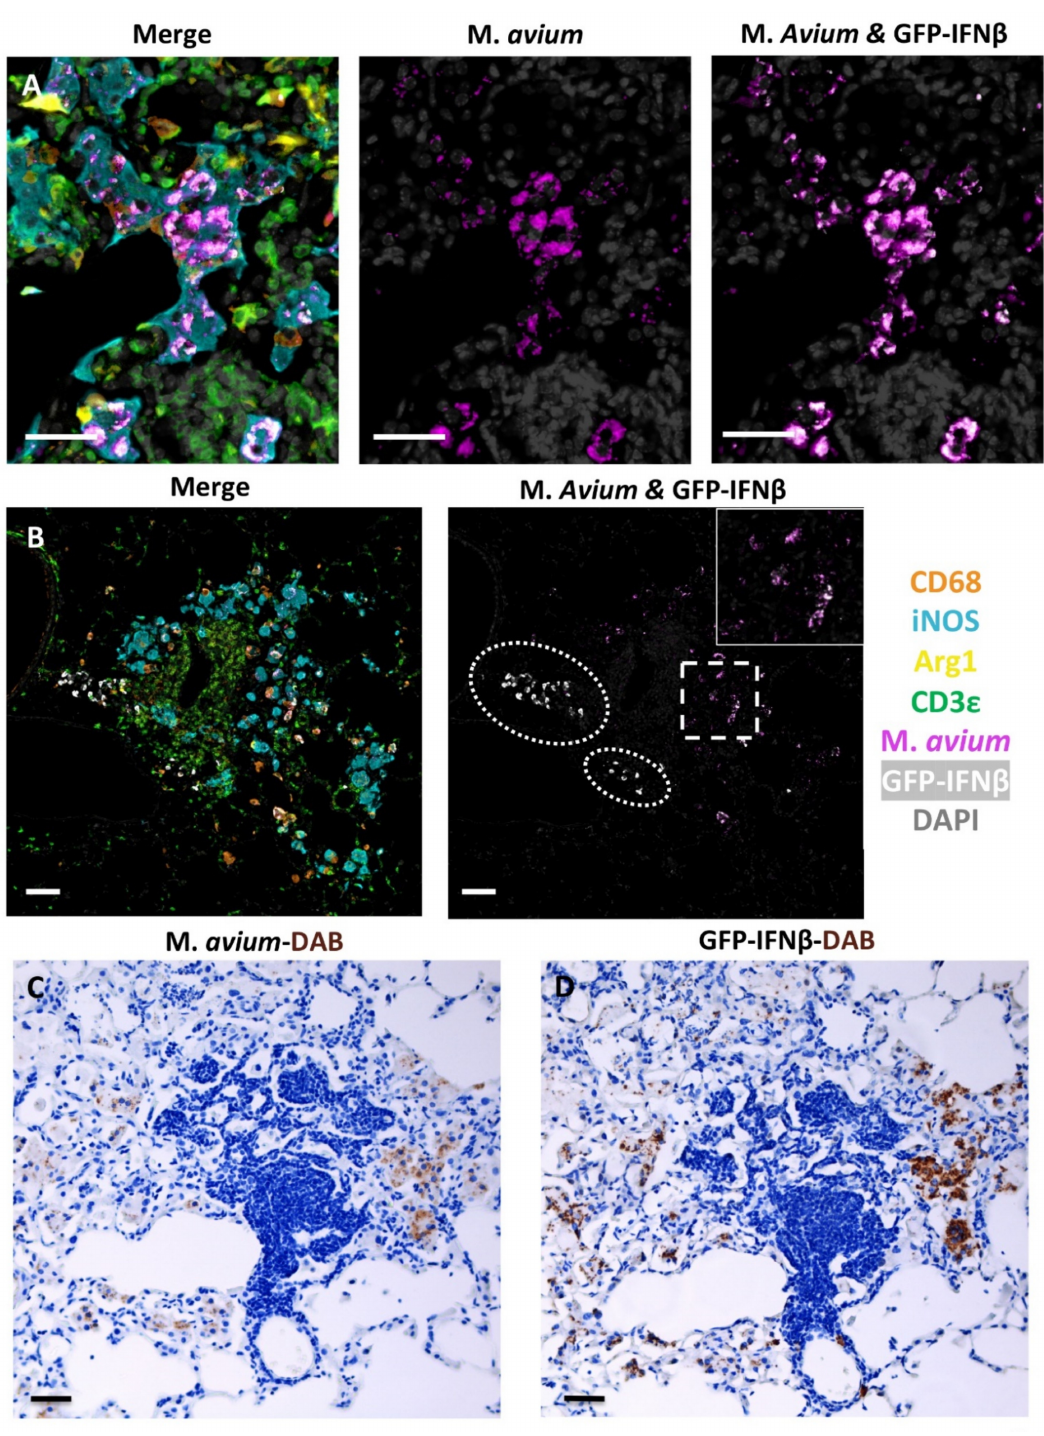
Figure 5. GFP-IFN β expression in B6.Sst1S.YFP-IFNß mice intrabronchially inoculated with M. avium at 23 weeks post-infection (wpi). ( A , B ) representative raw fluorescent multiplex immunohistochemistry (fmIHC) images. All filters on ( left - A , B ), M. avium only ( middle - A only) or M. avium and GFP-IFN β ( right - A , B ). ( A ) GFP-IFN β predominantly localized with iNOS+ M. avium + macrophages; ( B ) GFP-IFN β was also expressed in iNOS − /Arg − /CD3 ε − mononuclear infiltrate (white hashes); ( C ) M. avium − Diaminobenzidine (DAB) IHC.D: GFP-IFNß DAB IHC stain. ( C , D ) are serial sections illustrating GFP-IFNß expression predominates in macrophages with M. avium . ( C , D ) visualized with brightfield microscopy. Original magnifications 200 × ( A ) or 100 × ( B , C ) 400 × . Scale bars: 50 µ m ( A – C